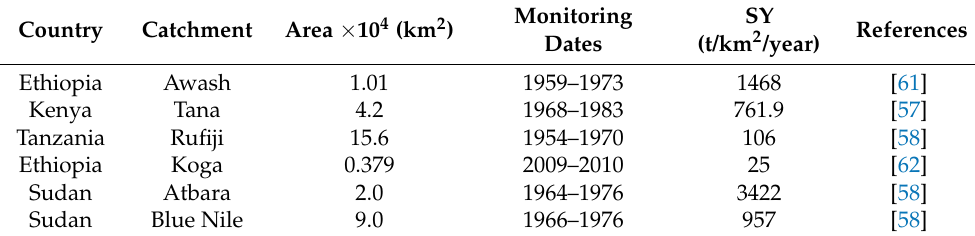
Table 1. Sediment yields in selected catchments in the East Africa region.